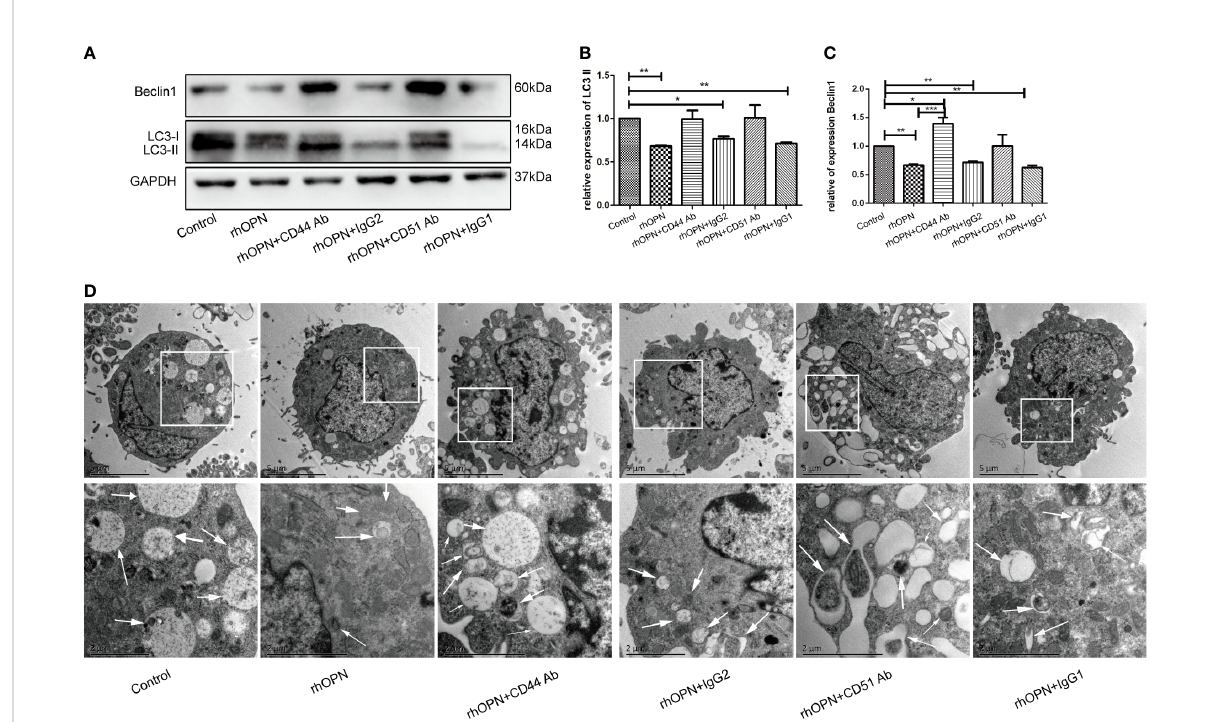
FIGURE 3 (A) Expression of Beclin1 and LC3 (both 3 repetitions) after each treatment, as determined by western blot analysis; (B) Expression of LC3 in each group; *indicates P < 0.05, **indicates P < 0.01, ***indicates P < 0.001 for the comparisons between the two groups; (C) Expression of Beclin1 in each group; *indicates P < 0.05, **indicates P < 0.01, ***indicates P < 0.001 for comparisons between the two groups. (D) The autophagosomes pointed by white arrows were shown by TEM images in